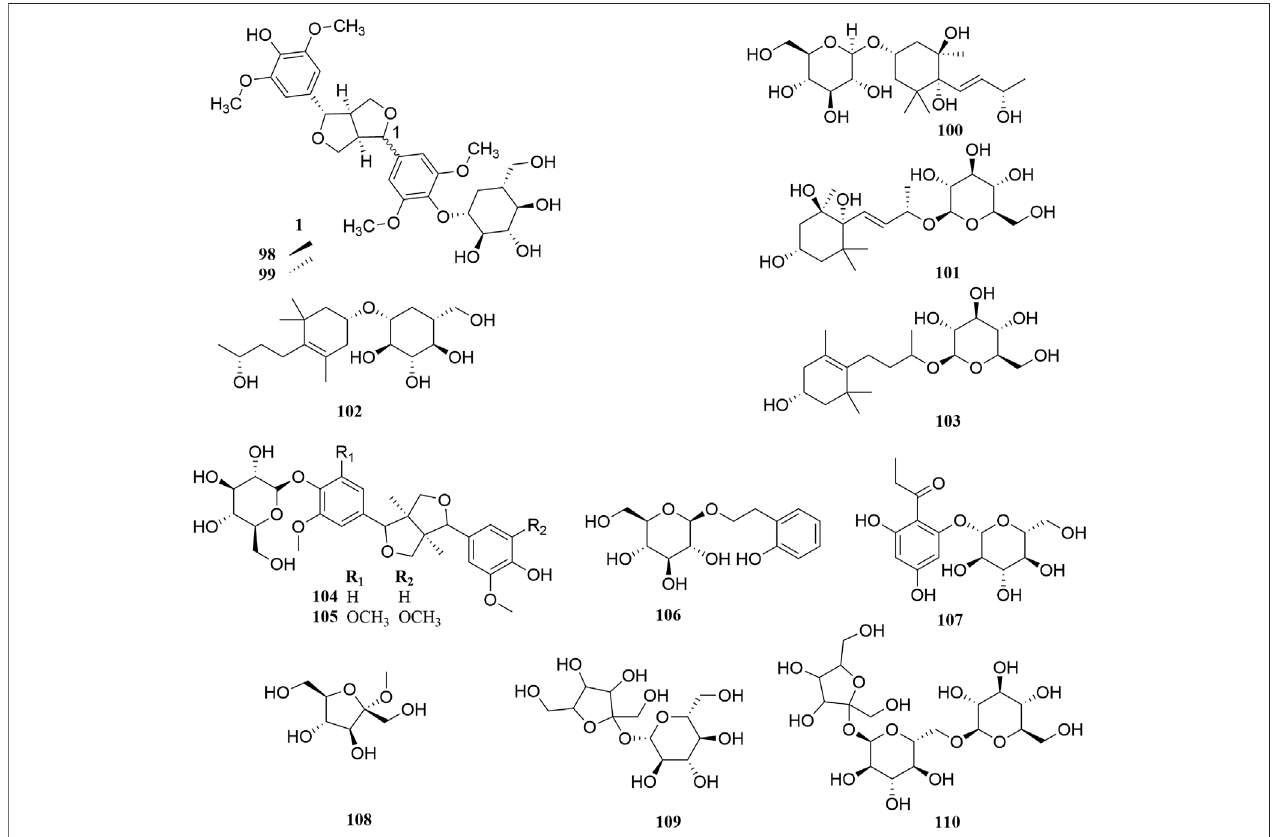
FIGURE 6 | Chemical structures of saccharides and glycosides ( 98 – 110